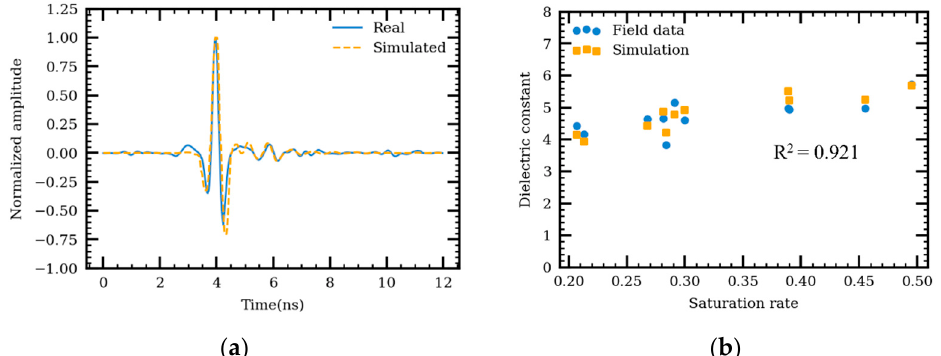
Figure 8. ( a ) A-scans from the field tests and simulations; ( b ) comparisons between the relative dielectric constants from the field tests and simulations.